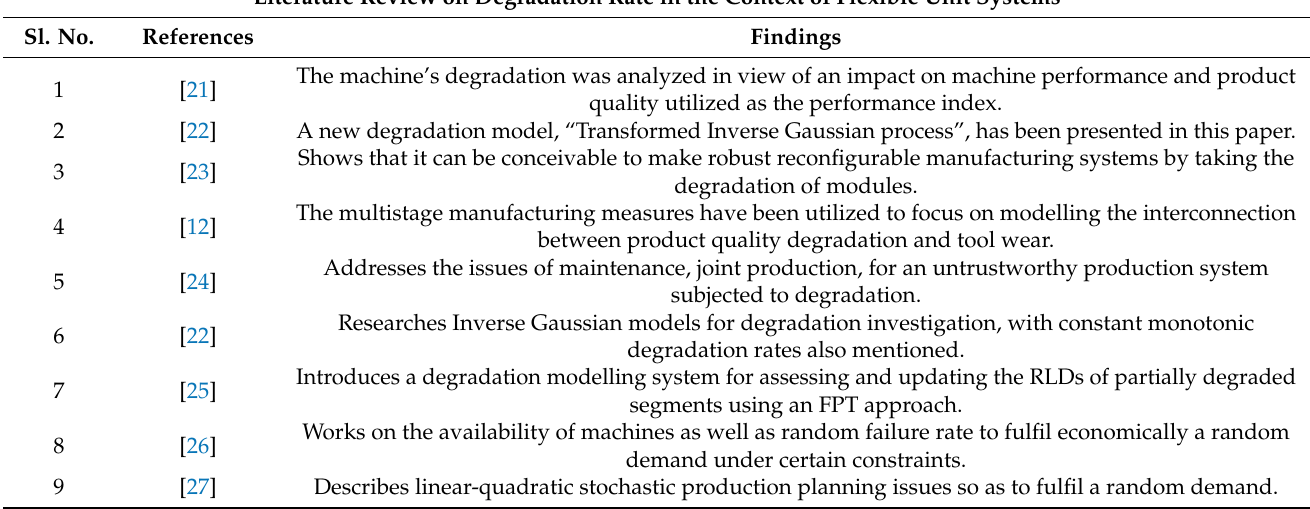
Table 6. Literature review on degradation rate related to flexible unit systems. Literature Review on Degradation Rate in the Context of Flexible Unit Systems Sl.